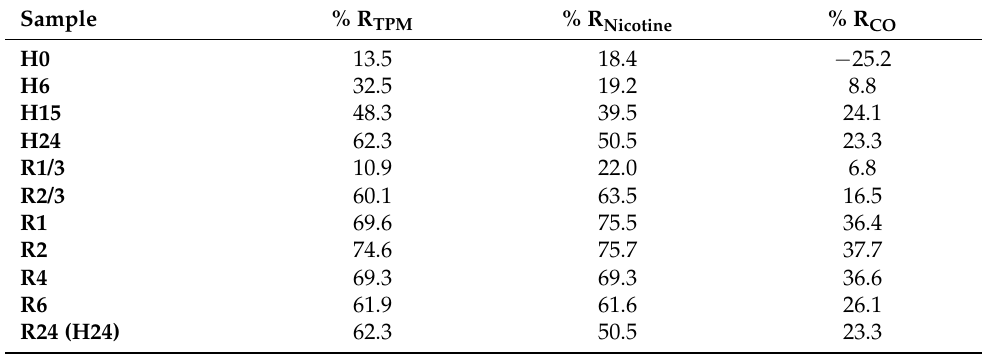
Table 2. Yield reductions obtained in the smoking process for the different catalysts studied.